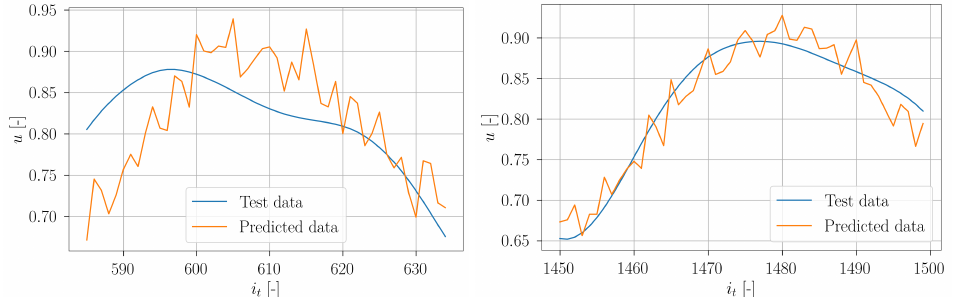
Figure 18. Timeseries reconstruction for setup 5 of the cylinder